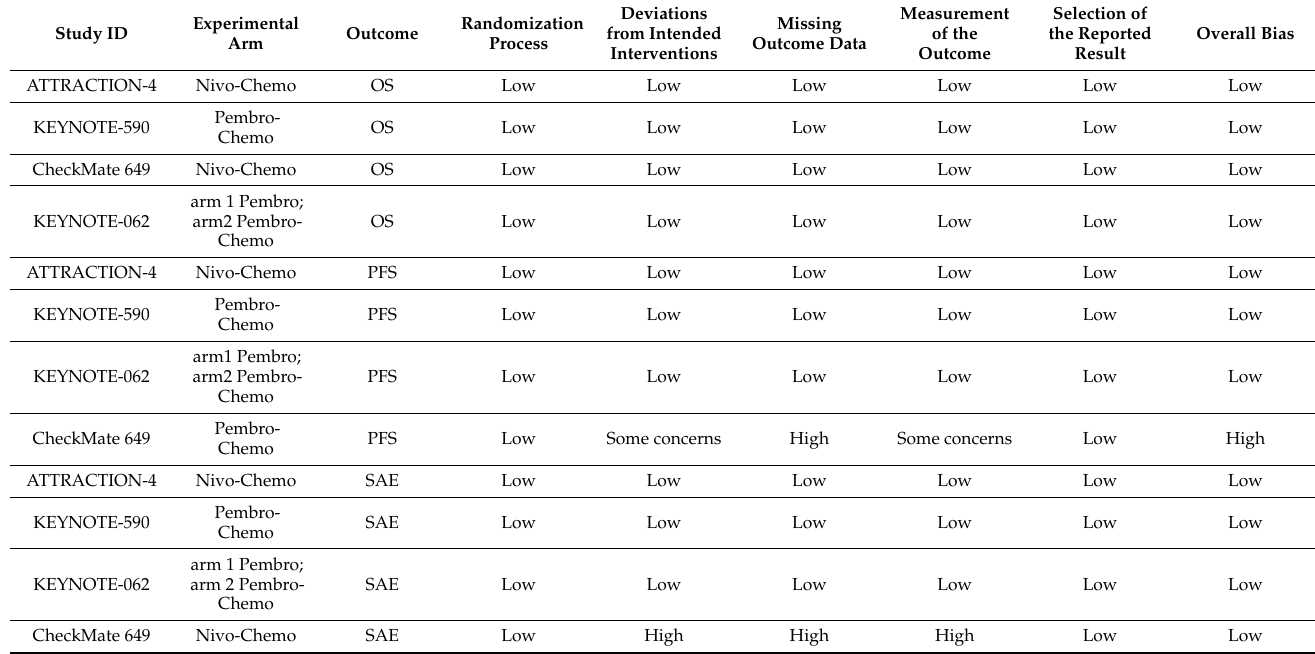
Table 2. Risk of bias assessment, first-line trials.